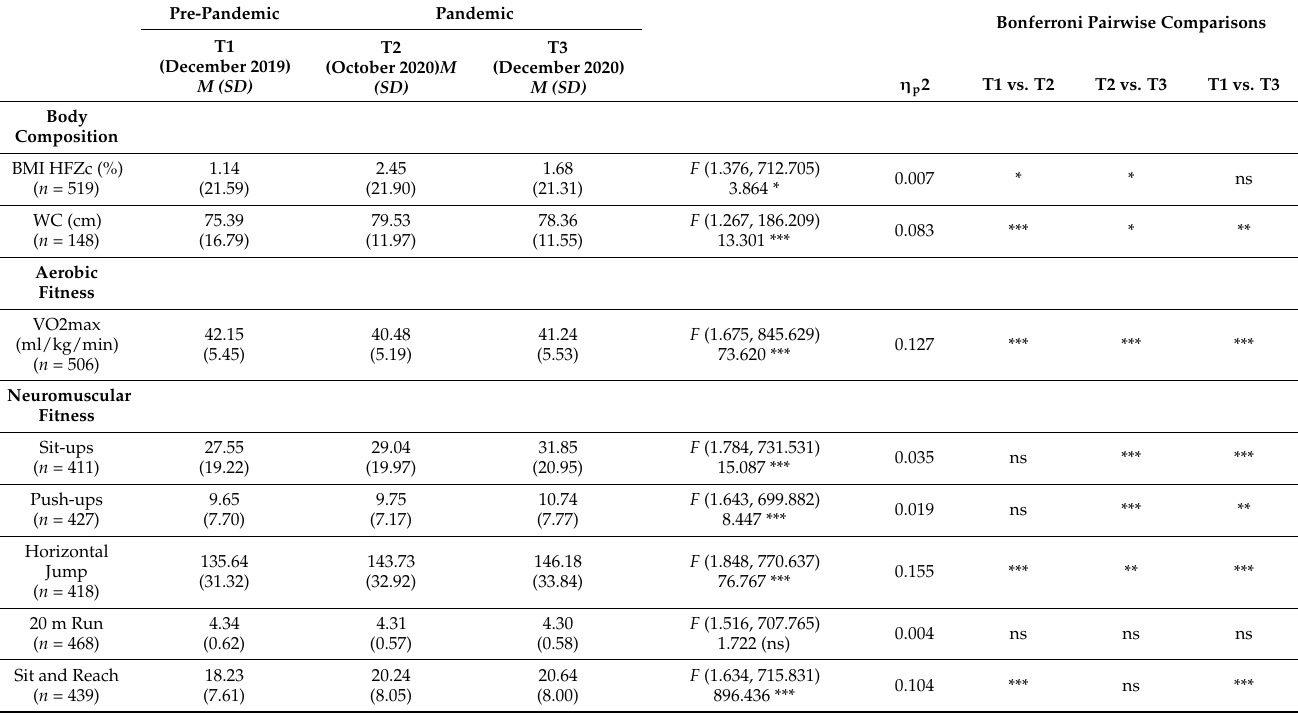
Table 2. Repeated measure ANOVA and Bonferroni Pairwise Comparisons for the total